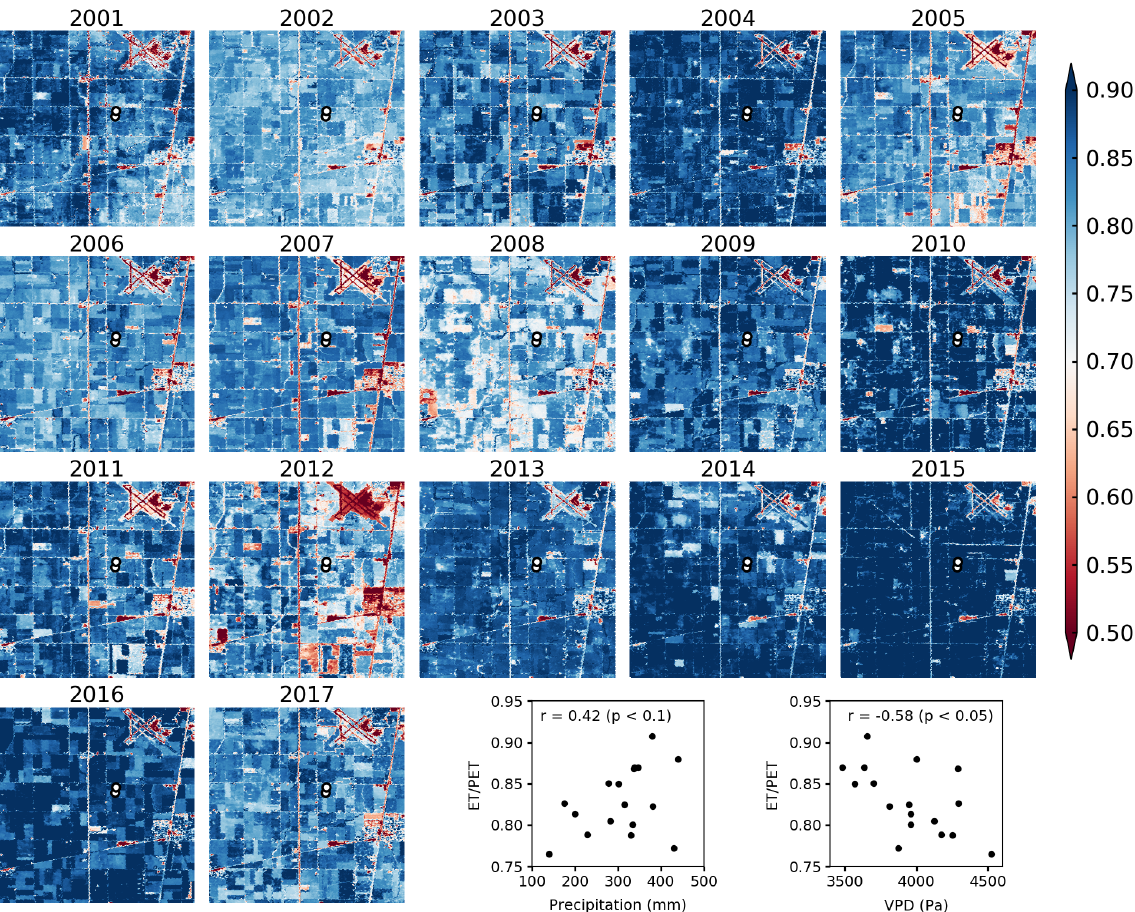
Figure 10. Peak growing season (June, July, and August) BESS-STAIR ET/PET at Bondville (39.95–40.05 ◦ N, 88.25–88.35 ◦ W) from 2001 through 2017 along with two scatter plots between peak growing season precipitation and ET/PET and peak growing season VPD and ET/PET over the 17 years. Precipitation and VPD data are from Daily Surface Weather Data (Daymet) at Bondville, Illinois (https: //modis.ornl.gov/cgi-bin/sites/site/?id=us_illinois_bondville&product=Daymet, last access: 11 March 2020), where VPD is derived using maximum air temperature and water vapor pressure. Circles indicate flux towers in this region.